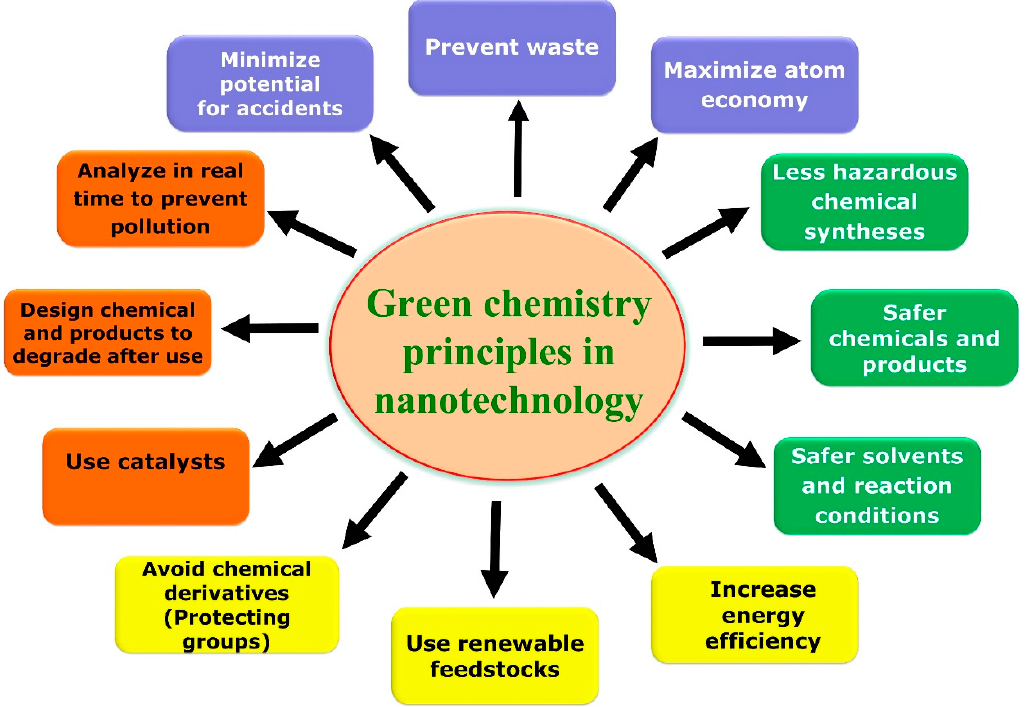
Figure 1. Overview of green chemistry principles applied in green